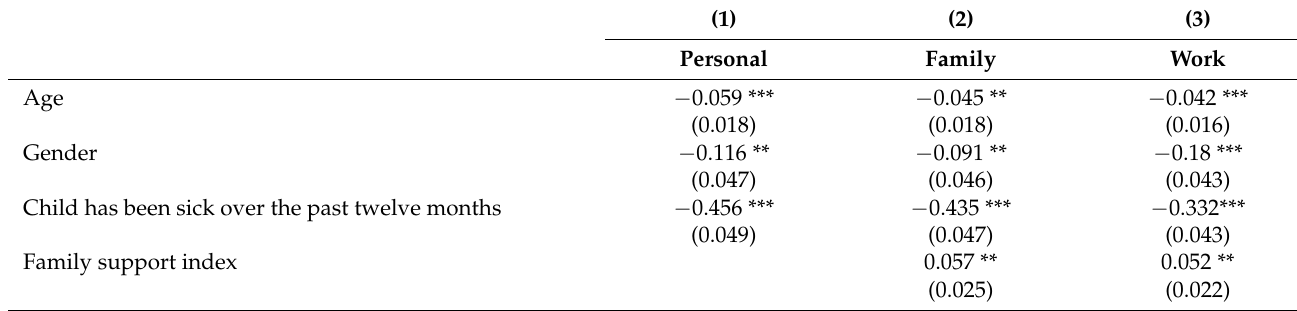
Table A4. Linear regression for emotionality